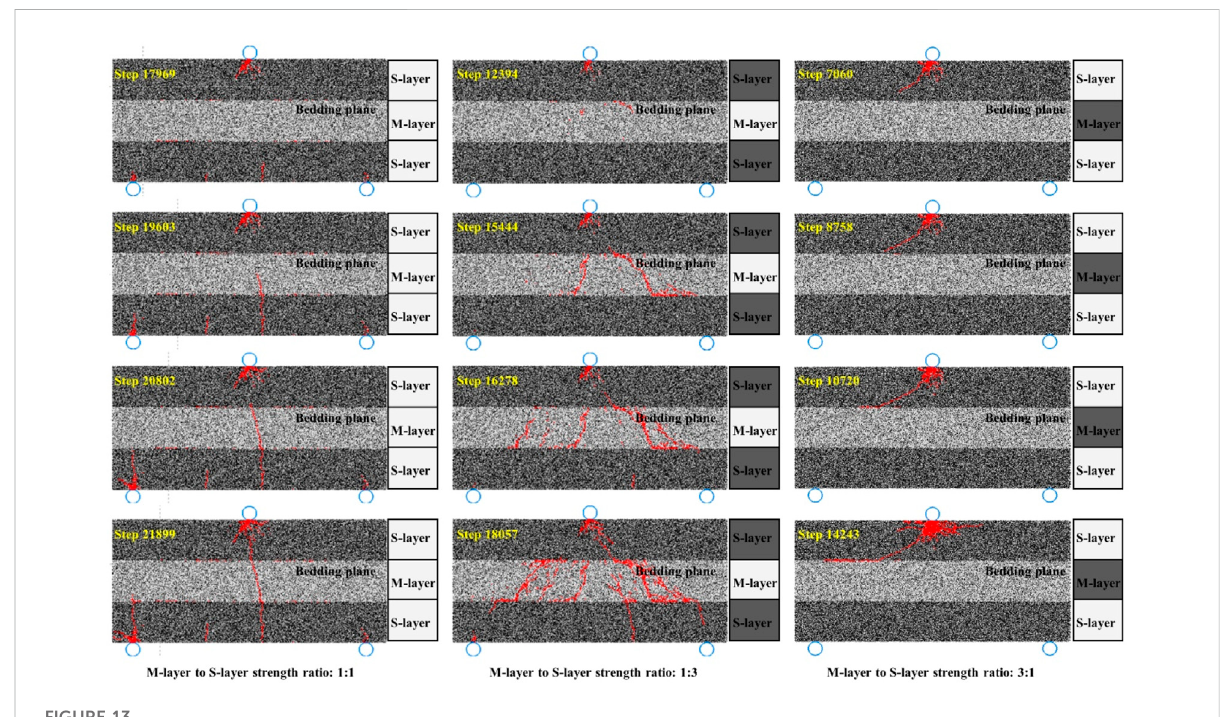
FIGURE 13 Crack propagation processes for different materials strength ratios.